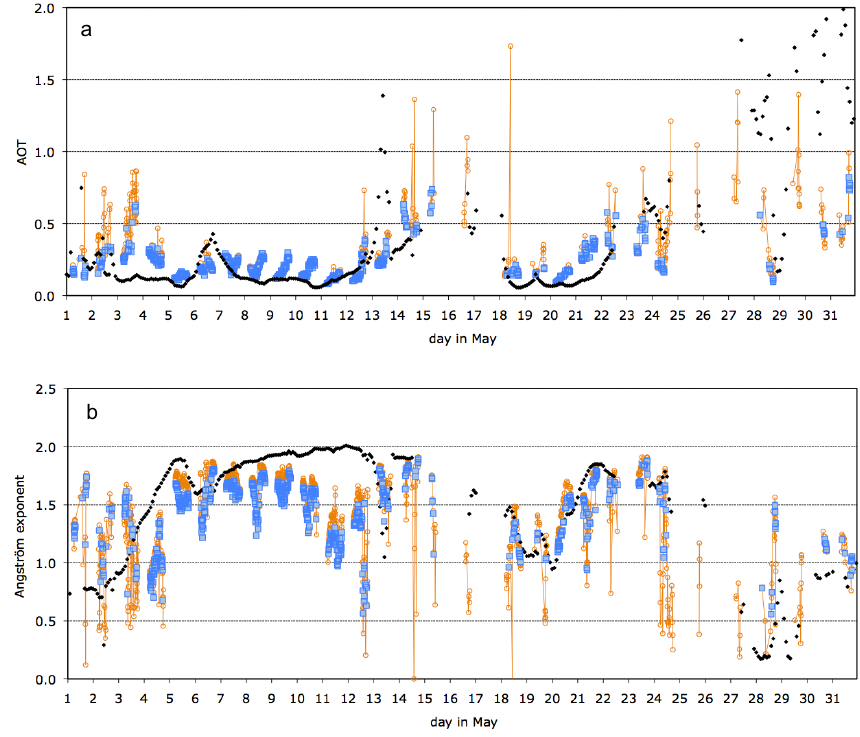
Fig. 2. (a) AOT (553nm) and (b) Angstr¨om exponent from the simulation (black) and from AERONET (orange: L1.5; blue: Figure 2. a) AOT and b) Angström exponent from the simulation (black) and from AERONET (orange: L1.5; blue: L2.0)